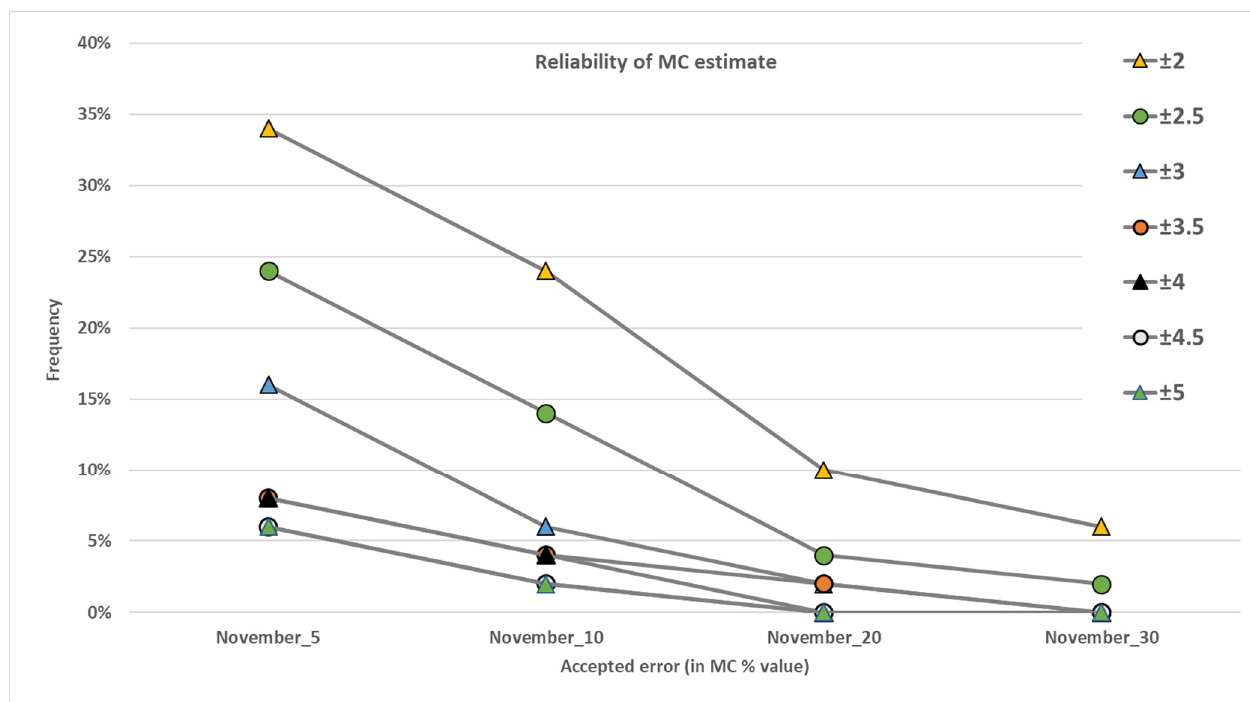
Figure 9. Sensitive analysis of MC estimation accuracy of the Summer pile based on the average of an increasing number of samples (5, 10, 20 and 30). Trend lines show the result according to different error tolerance levels.